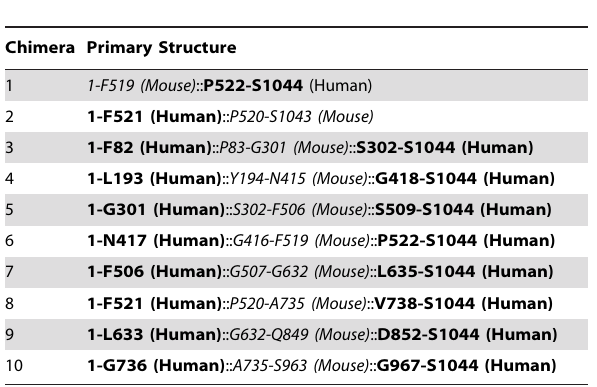
Table 2. Human/mouse b -Klotho chimeras used to determine Avimer binding site.